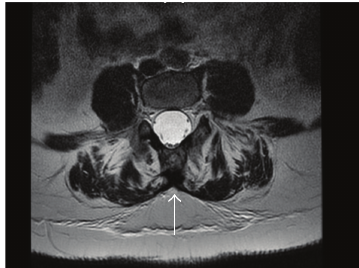
Figure 2: The patient’s MRI transversal view: evidence of sacral bone